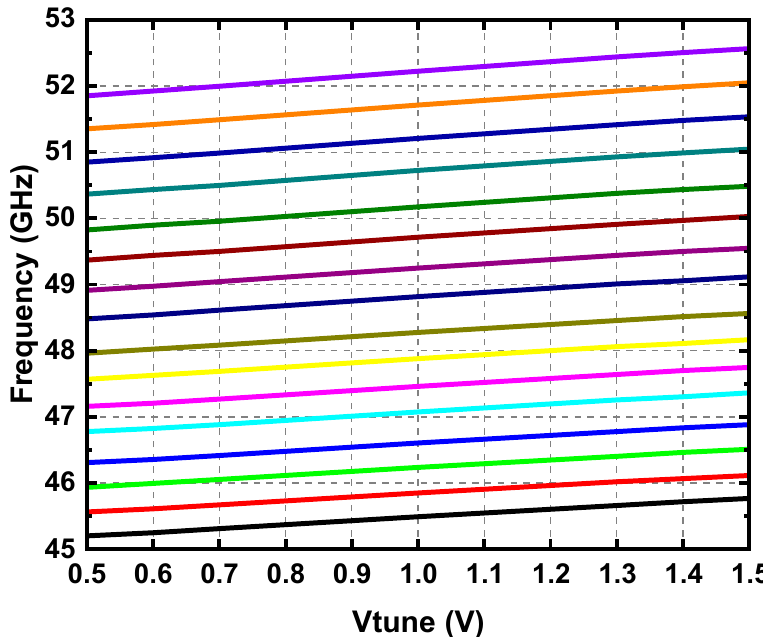
Figure 8. Simulated frequency tuning curve of VCO.